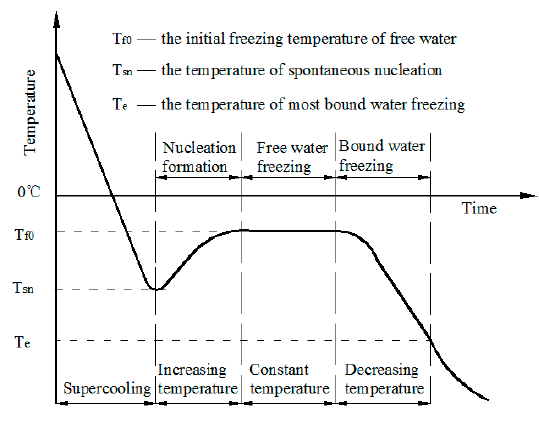
Figure 3. Cooling curve for the soil–water system.